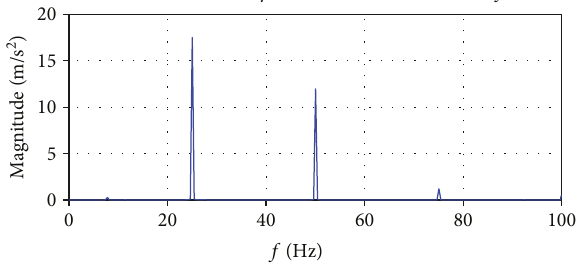
Table 4: D5, superharmonic contributions, sine excitation tests. superharmonic